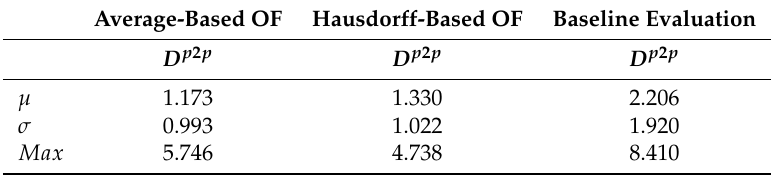
Table 13. Numerical evaluation: Pair-wise distance (in mm) between predicted PCLs and post-surgery models using MOR. The training set is sampled with rate of 65% and 75% due to average and Hausdorff OFs, respectively.